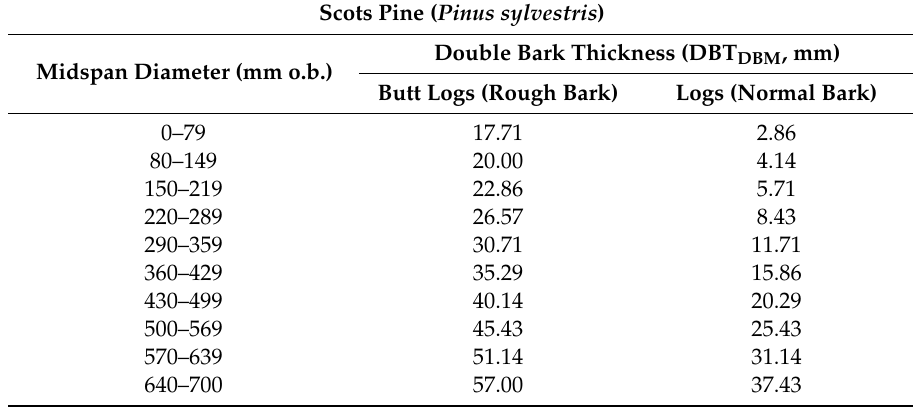
Table 2. The double bark thickness values of the diameter band bark deduction method (DBM) used for under-bark volume estimation of Scots pine timber in harvester systems according to the GEH [30]. The values for each diameter band vary depending on whether it is a butt log with rough bark or a log with normal bark